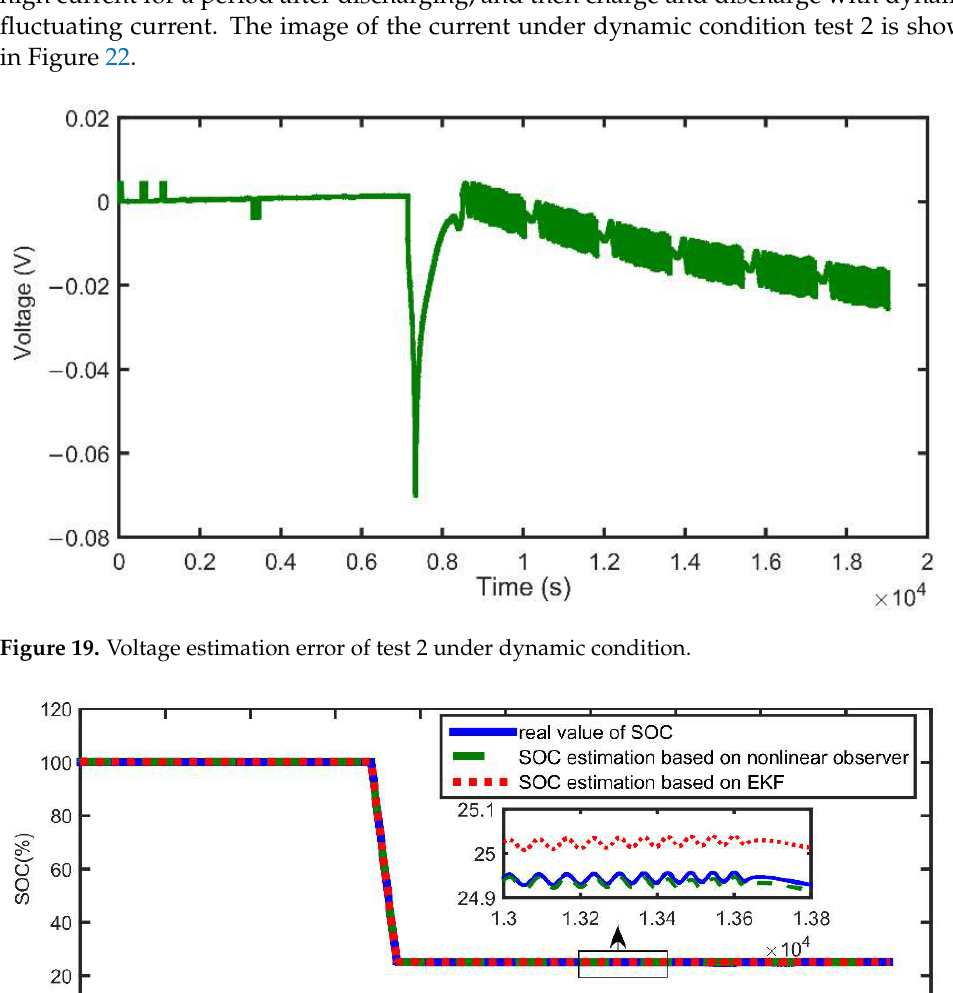
Figure 20. Comparison of SOC estimation based on non-linear observer and EKF in dynamic con- dition test 2.